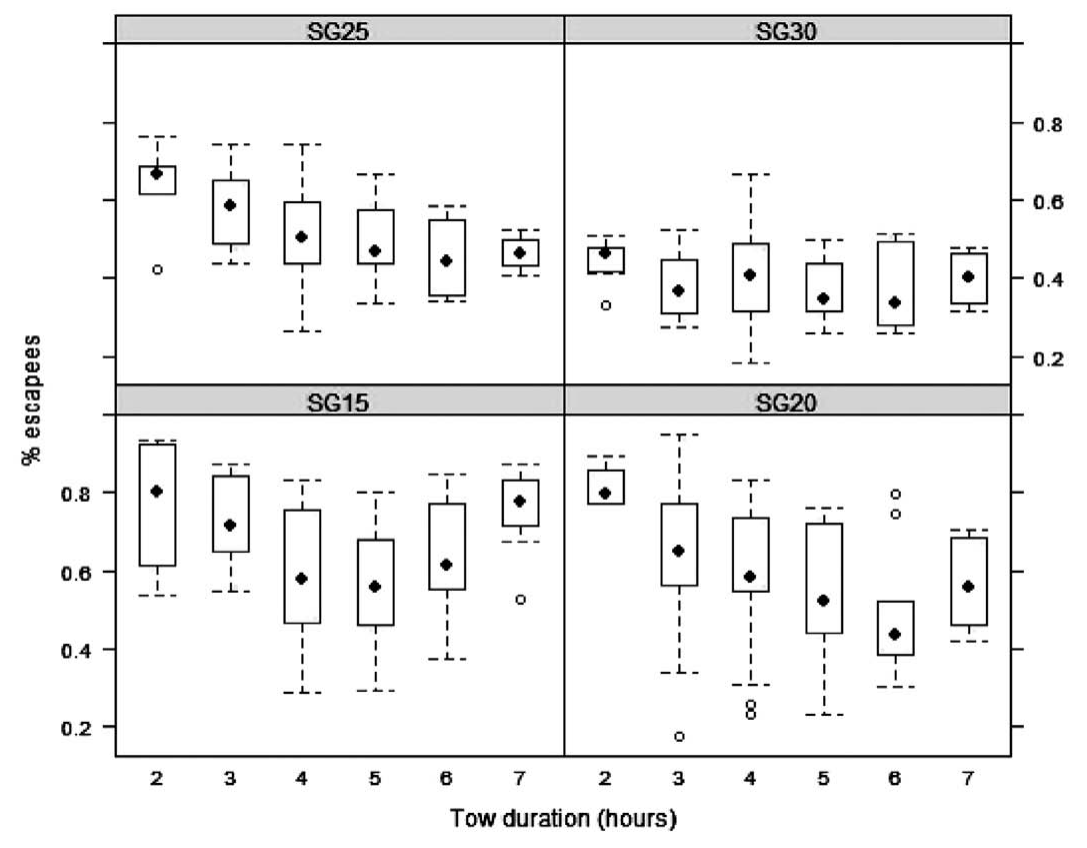
Fig. 4. – Percentage of escaped individuals and tow durations for each sorting grid (SG 15 SG 20, SG 25 and SG 30 corresponding to 15-, 20-, 25- and, 30-mm bar spacing,